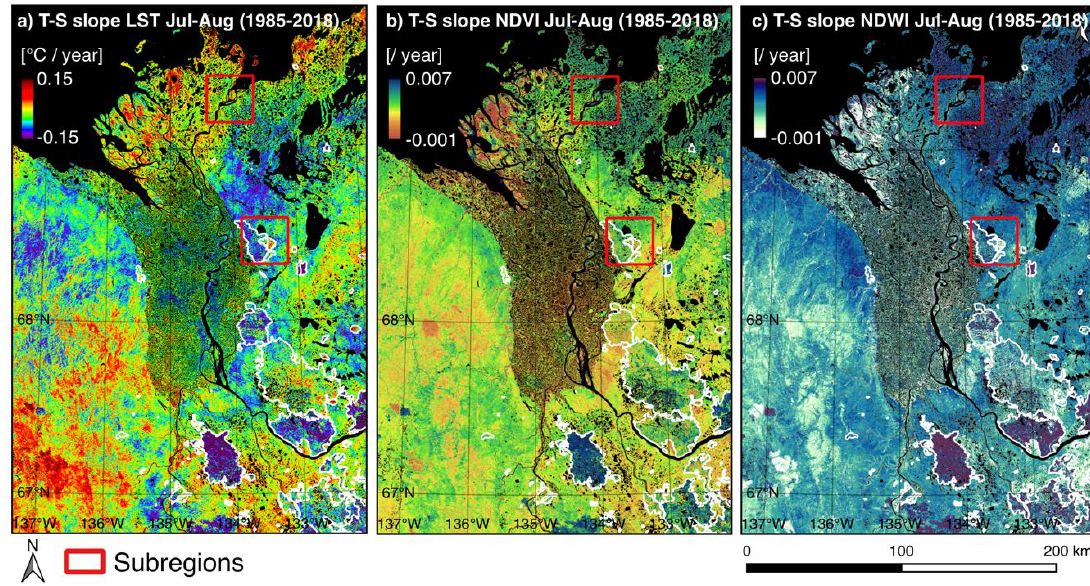
Figure 7. Theil-Sen trend slopes of ( a ) summer LST, ( b ) NDVI, and ( c ) NDWI. The boundaries of areas affected by former wildfires are highlighted in white, whereas the red boxes highlight the subregions shown in Figures 8 and 9.